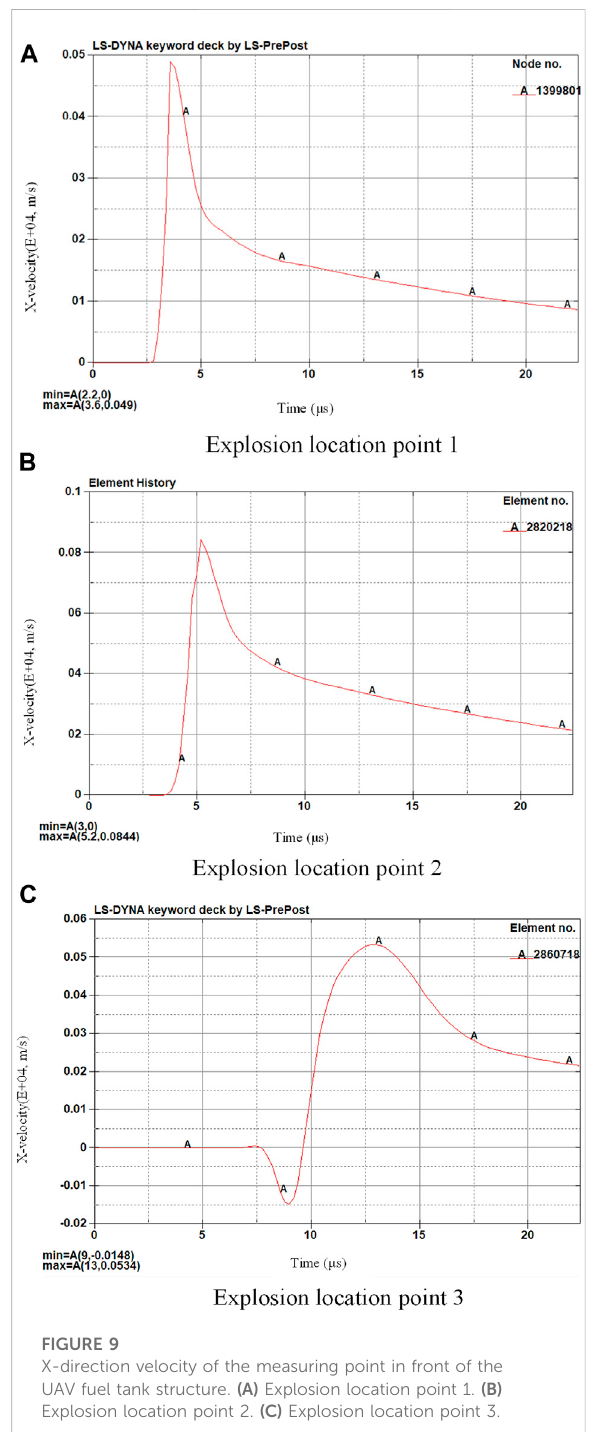
tankstructure. (A) Explosionlocationpoint1. (B) Explosionlocation point 2. (C) Explosion location point 3.